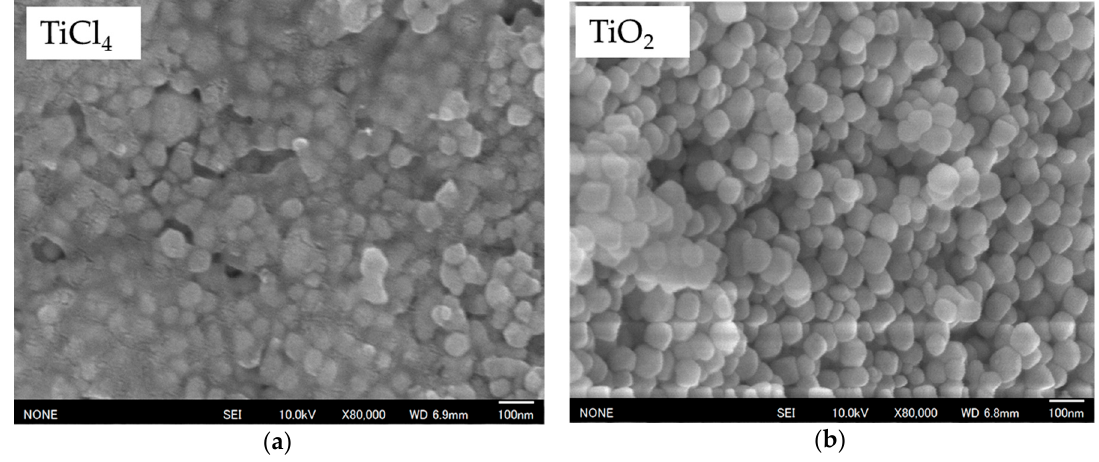
Figure 2. FE-SEM images of hydrothermally synthesized BT-PVP particles using different Ti sources for 5 h: ( a ) by TiCl 4 ; ( b ) by TiO 2 .